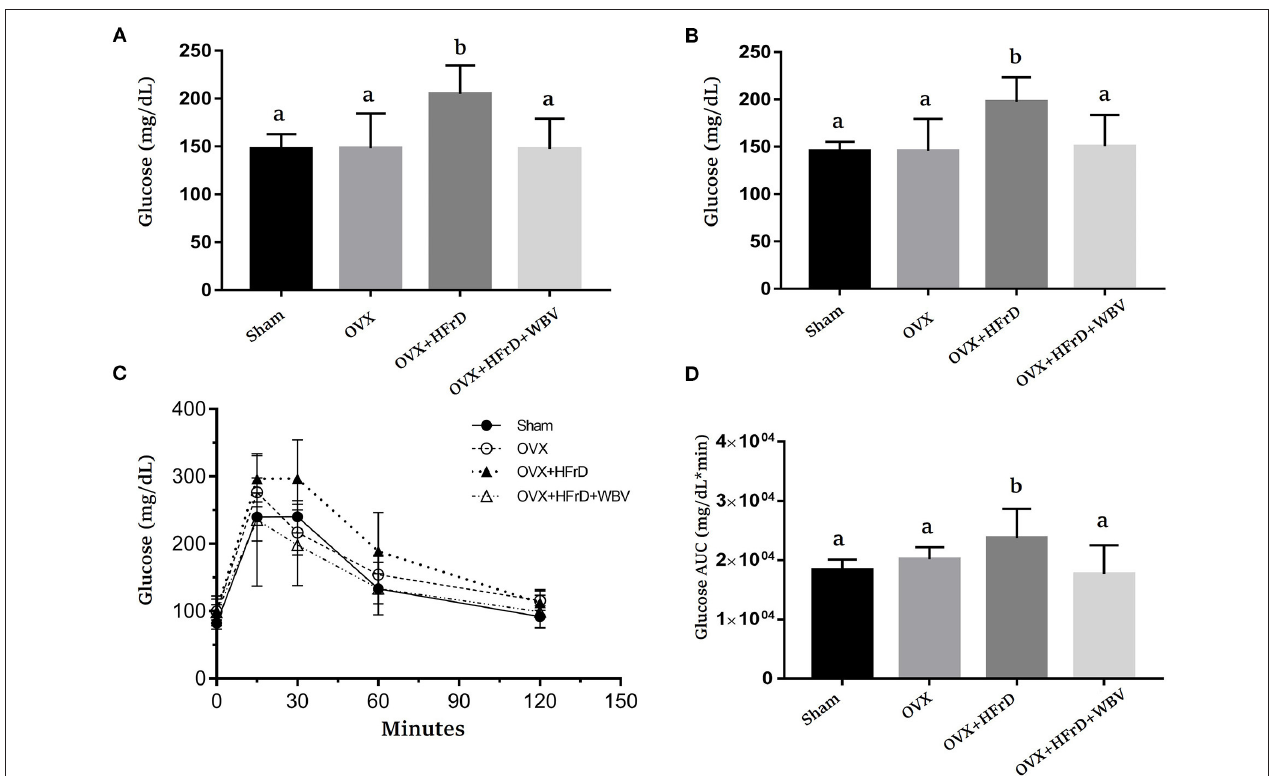
FIGURE 3 | The effects of whole-body vibration (WBV) combined with a high-fructose diet (HFrD) on ovariectomized (OVX) mice in terms of glucose level and tolerance. The glucose levels were evaluated at weeks 6 (A) and 12 (B) , and glucose tolerance (C) and the area under the curve (AUC) (D) were assessed at week 15. The data are presented as means ± SD. Different superscript letters indicate significant differences ( P < 0.05), as indicated by a one-way analysis of variance.